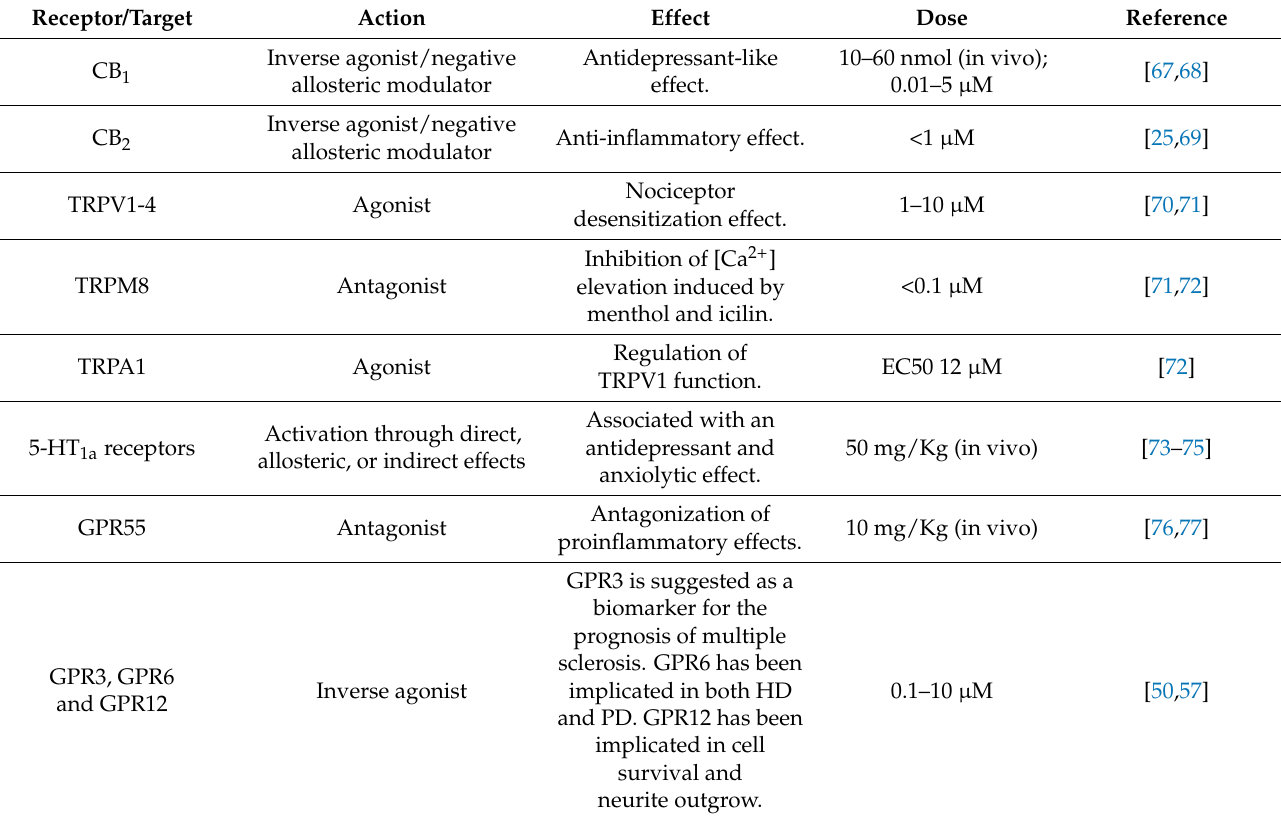
Table 1. CBD interaction with receptors and targets and their